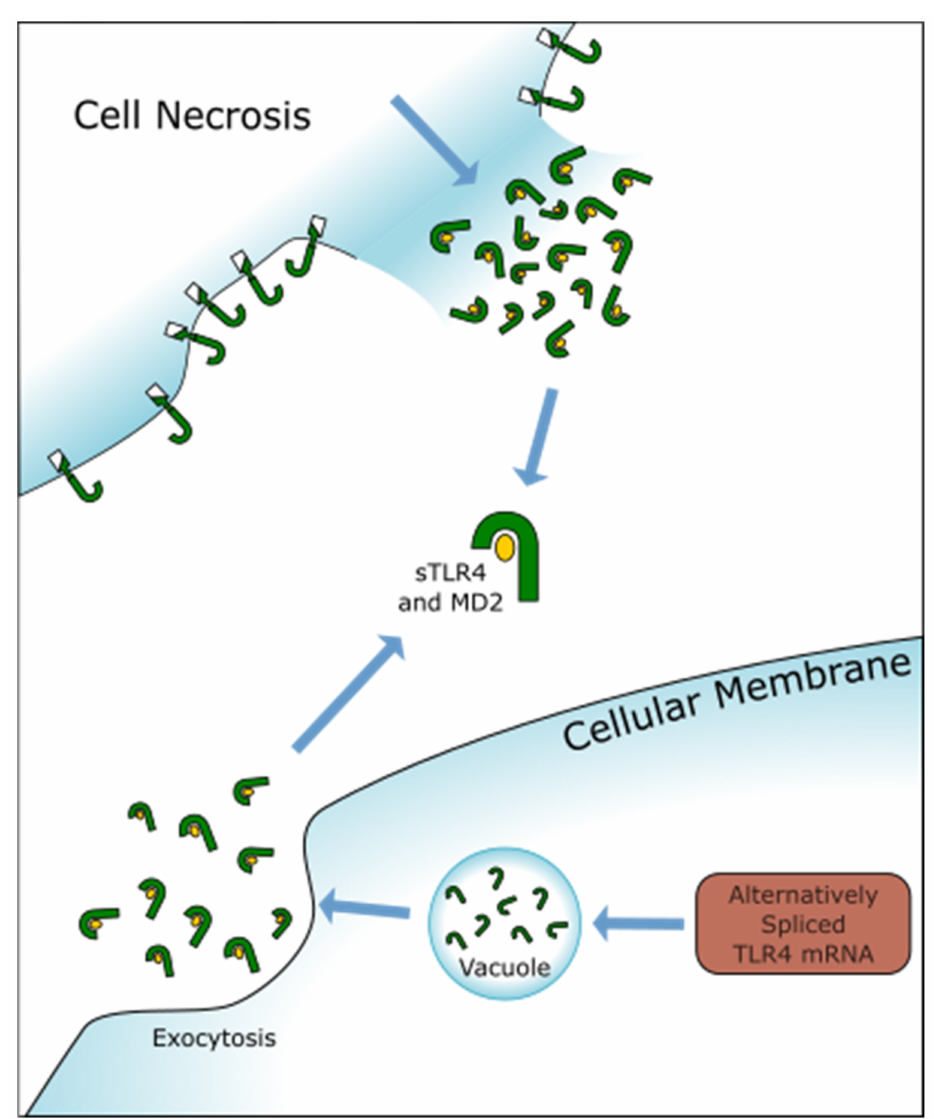
Figure 3. Illustration of the other two reported sources of sTLRs, cell necrosis, and alternatively spliced TLRs. It should be noted that necrosis is thought to only account for a small portion of the sTLR produced in humans, and alternatively spliced sTLR has only been observed in a murine